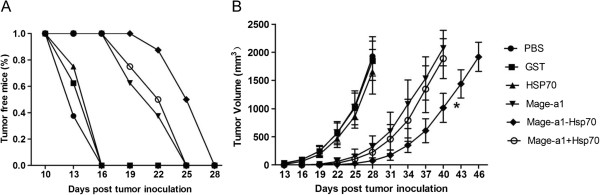
Prophylactic immunization with Mage-a1-Hsp70 fusion protein protects mice against B16-Mage-a1 tumor cell challenge. C57BL/6 mice were immunized with purified GST, Hsp70, Mage-a1, Mage-a1-Hsp70 fusion protein or Mage-a1 + Hsp70 and then administered a booster immunization after one week. A week after the booster, the mice were challenged with 1 × 105 B16-Mage-a1 melanoma cells. A. The tumor free status of mice was recorded as the percentage of mice remaining tumor-free every three days after tumor challenge. B. Tumor growth was recorded as the mean tumor volume (in mm3). Error bars depict the SE, n = 8 mice/group. Statistical analysis by two-way ANOVA revealed that from days 31 to 37 vaccination with Mage-a1-Hsp70 significantly delayed tumor growth in the B16-Mage-a1 tumor model compared to vaccination with Mage-a1 or Mage-a1 + Hsp70 (* p < 0.01).